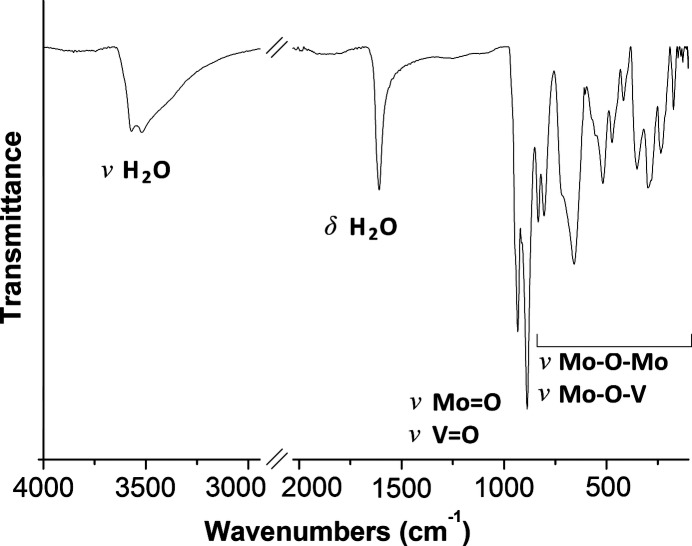
The IR spectrum of VMo7 in the region 4000–100 cm−1.